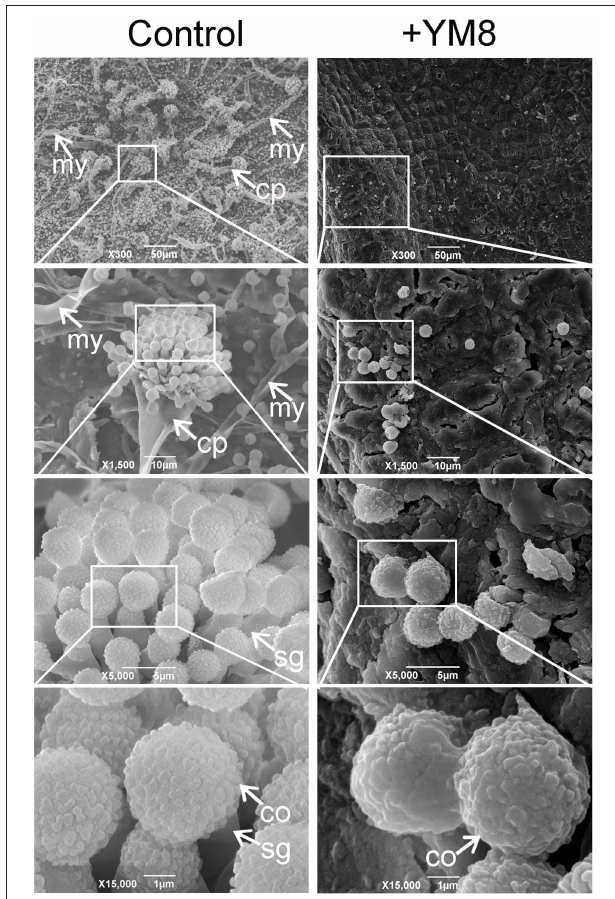
FIGURE 6 | Scanning electron micoscopy of Aspergillus flavus infecting peanuts. Peanuts with water activity (a w ) of 0.934 were inoculated with A. flavus conidia and incubated in the presence or absence (control) of strain YM8 for 7 days. co, conidia; cp, conidiophore; my, mycelia; sg,